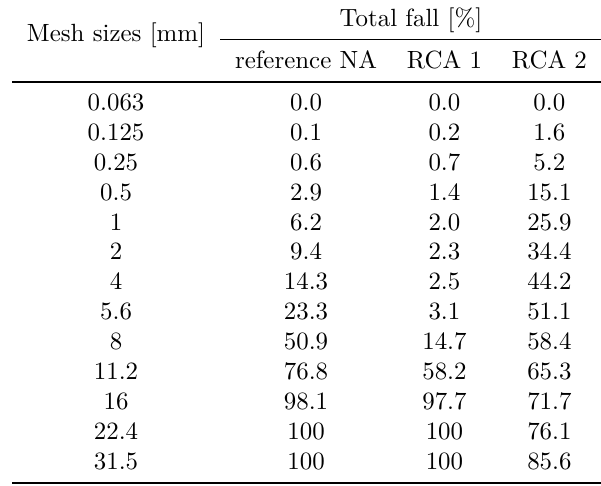
Table 2. The results of the screening analysis of aggregates.